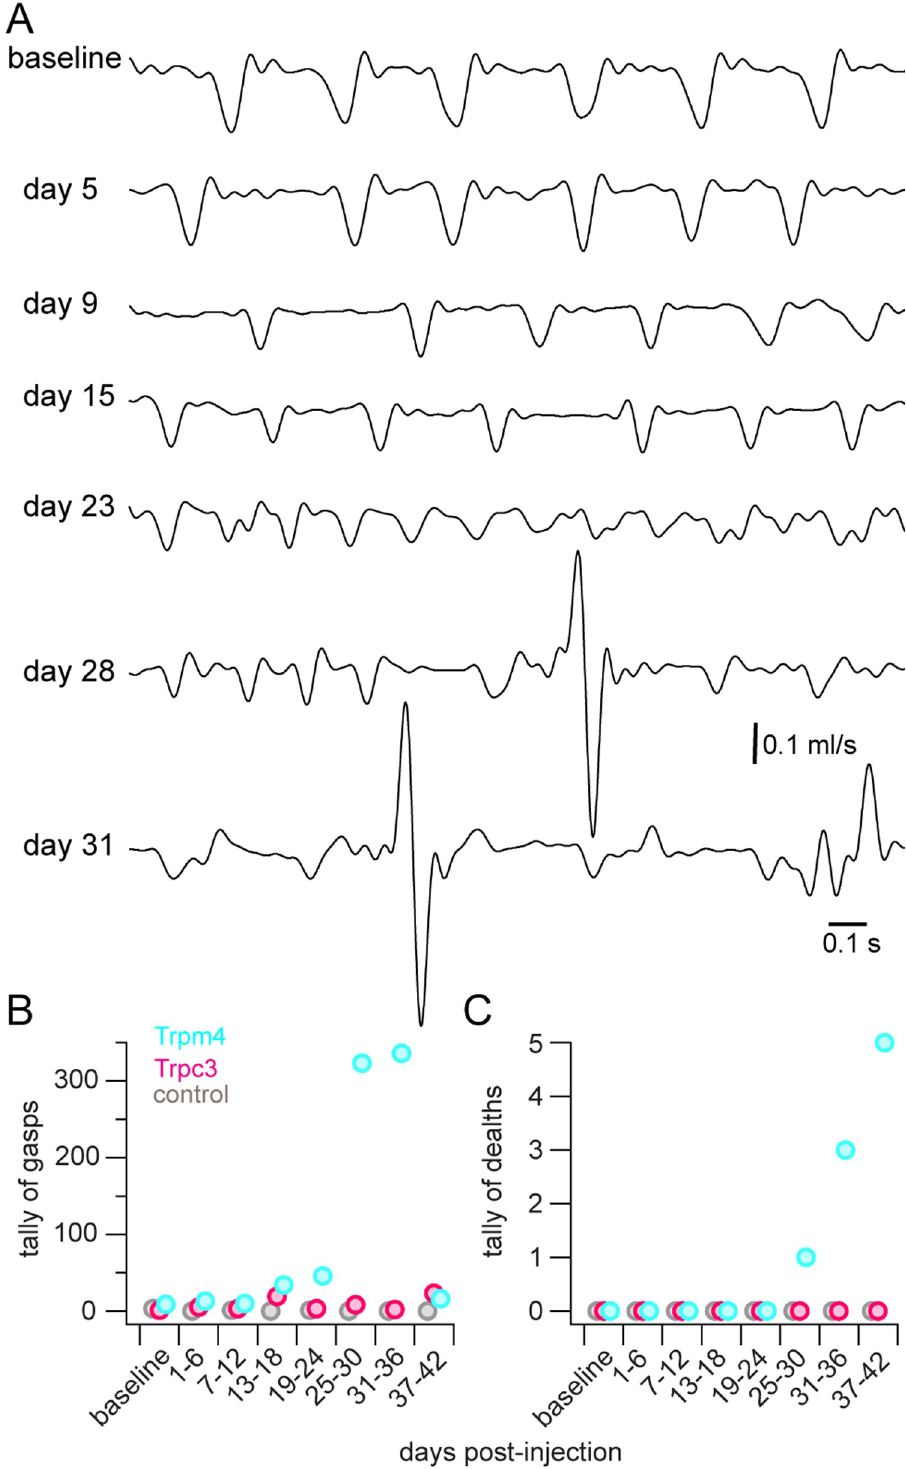
Fig 5. Longitudinal study of breathing in a Trpm4 shRNA-injected mouse. (A) Breathing at different time points from before injection (baseline) until day 31 after injection of Trpm4 shRNA in an adult CD-1 mouse. Gasps on days 28 and 31 are recognized by rapid active exhale (upward trajectory before inspiration), followed by inhale (downward trajectory) efforts. This mouse died on day 32. (B,C) Group data showing tallies of gasps (B) and deaths (C) in mice